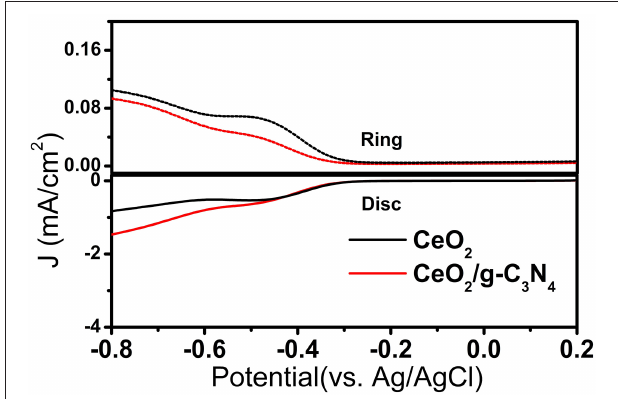
FIGURE 6 | RRDE Comparison of CeO 2 and CeO 2 /g-C 3 N 4 systems.